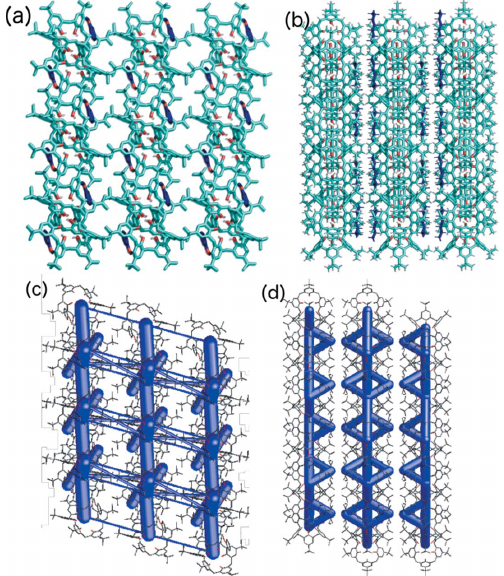
Figure 9 ( a ), ( b ) The crystal packing and ( c ), ( d ) the crystal frameworks of 9 and 10 viewed along the [001] axis. Disorder has been removed for clarity.